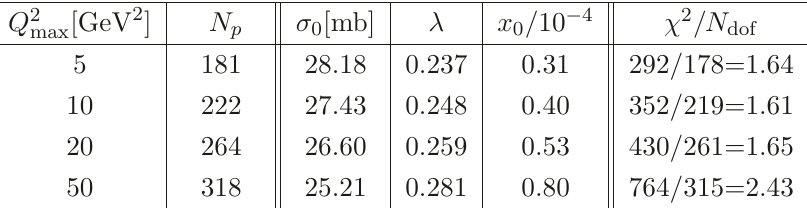
Table 2 . Sensitivity of the quality of Fit 2 from table 1 to the choice of Q 2 the number of experimental points selected by Q 2 max